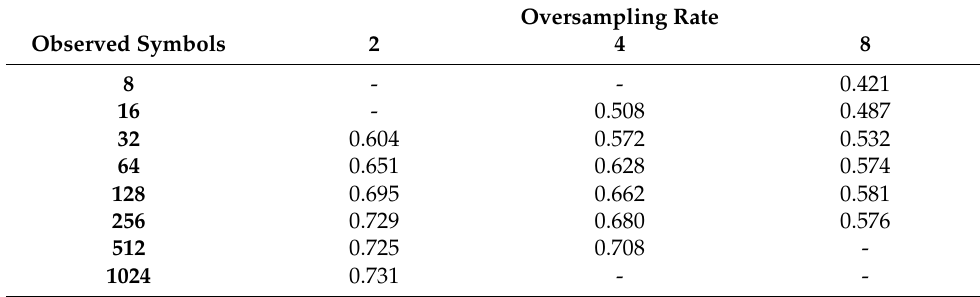
Table 4. PCC of observed symbols for networks trained on 128 samples.